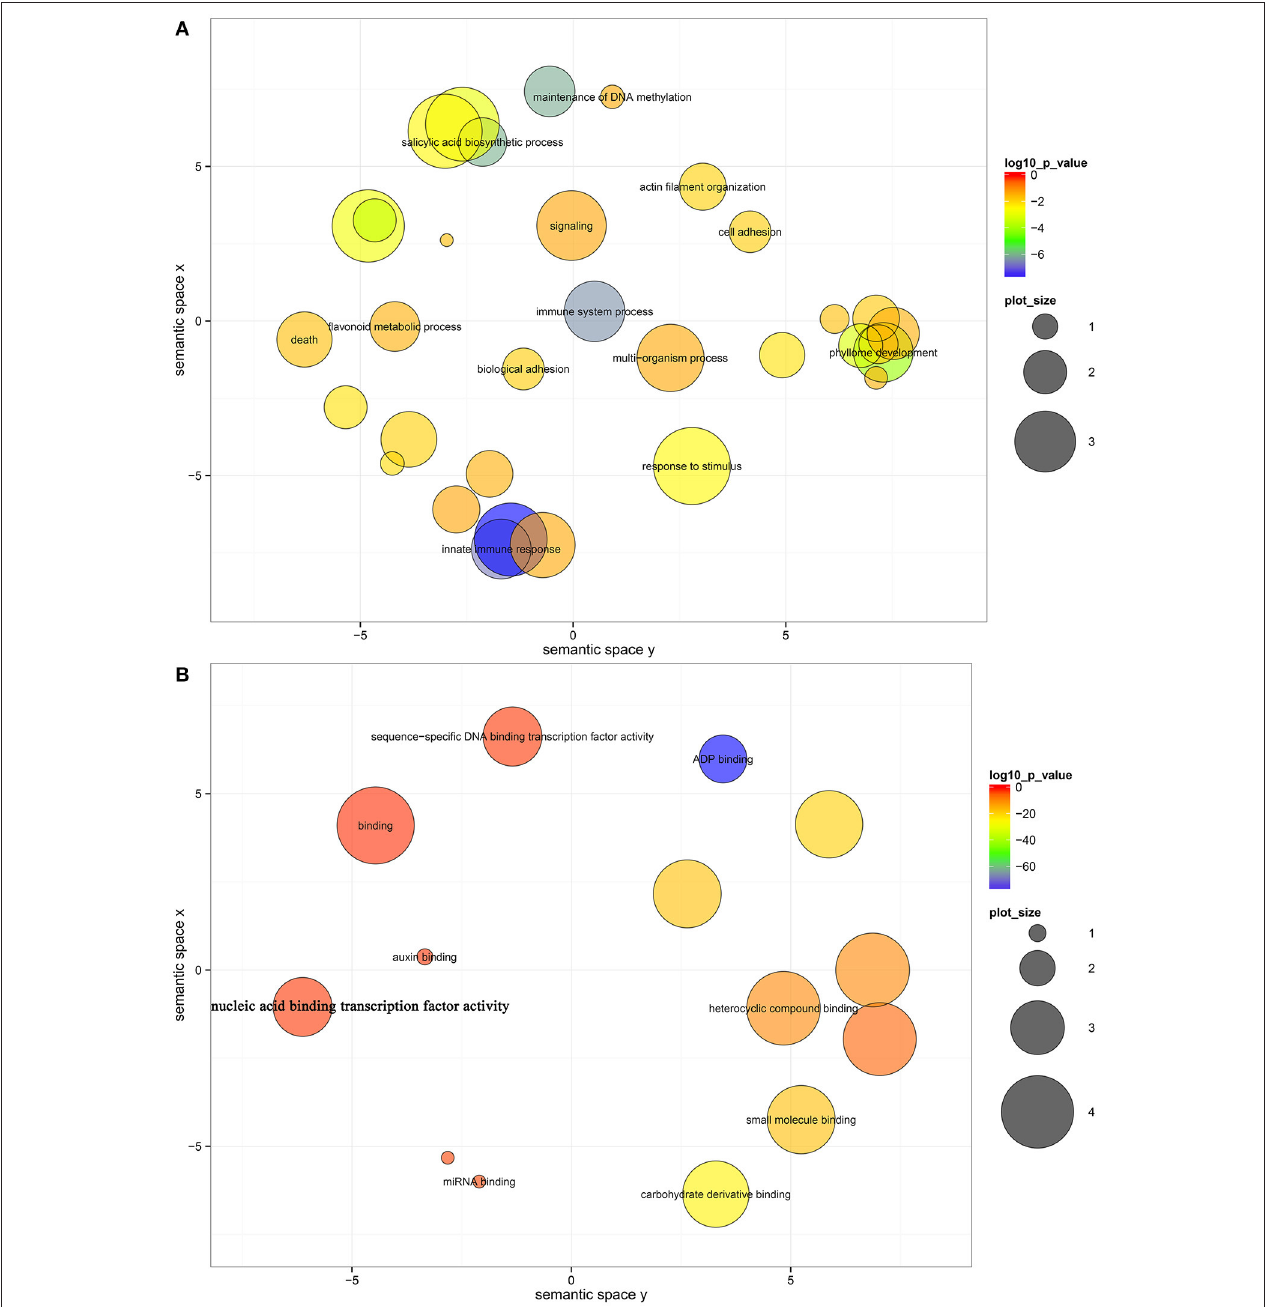
FIGURE 3 | Biological process (A) and molecular function (B) enrichment analysis of the target genes of miRNAs. The bubble color indicates the P -value; the plot size indicates the frequency of the GO term in the underlying GOA database (bubbles of more general terms are larger). Csi-miR159 also targeted four genes, including two GAMYBs indicated that the targets of one miRNA had similar function (Cs1g03470 and Cs3g06390) which play a central role during ( Table 3 fruit ripening of strawberry (Vallarino et al., 2015). ATHB8/14/15 (Cs4g19310, Cs2g09770, and Cs1g15640) were the targets of csi- miR166d and are involved in vascular development and auxin signaling (Ohashi-Ito and Fukuda, 2003; Baima et al., 2014). Csi- miRN21 targeted three disease resistance proteins. These results